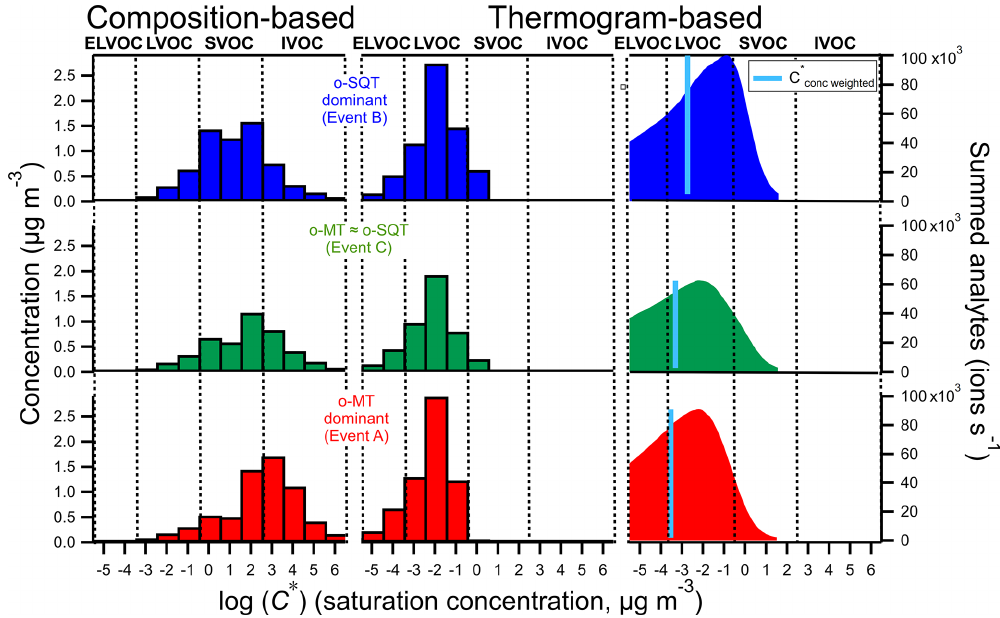
Figure 7. Volatility distribution of analytes measured in the particle phase during the three event periods on 15–18 May 2018 (top: SQT event B; middle: mixed event C; bottom: MT event A), derived using two fundamentally different methods (based on tentatively assigned composition and based on thermograms ( T max ) as described in Sect. 2.3). The right plots were obtained by converting the desorption temperatures to C ∗ (Sect. 3.2.4). The blue line indicates the C ∗ weighted by the summed